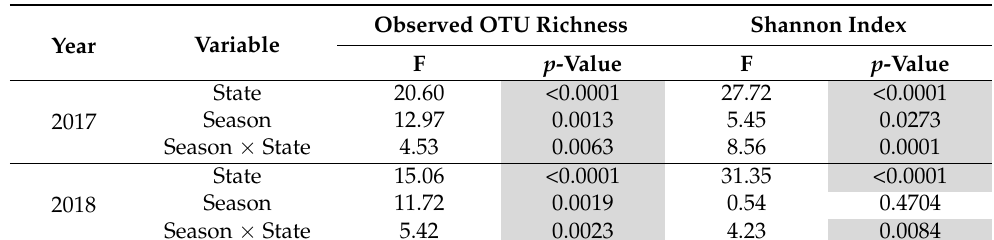
Table 2. Analysis of variance on two alpha diversity indices among five states and between two seasons and their interactions by year.